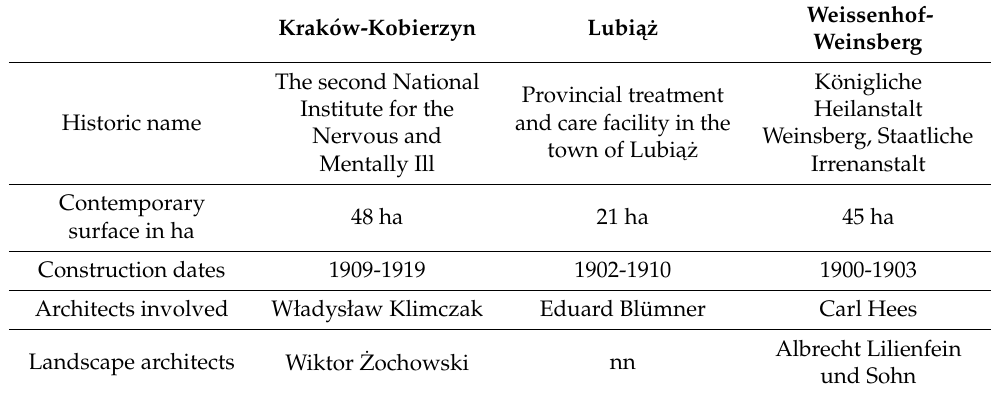
Table 1. An overview of the historic mental hospitals and their gardens under